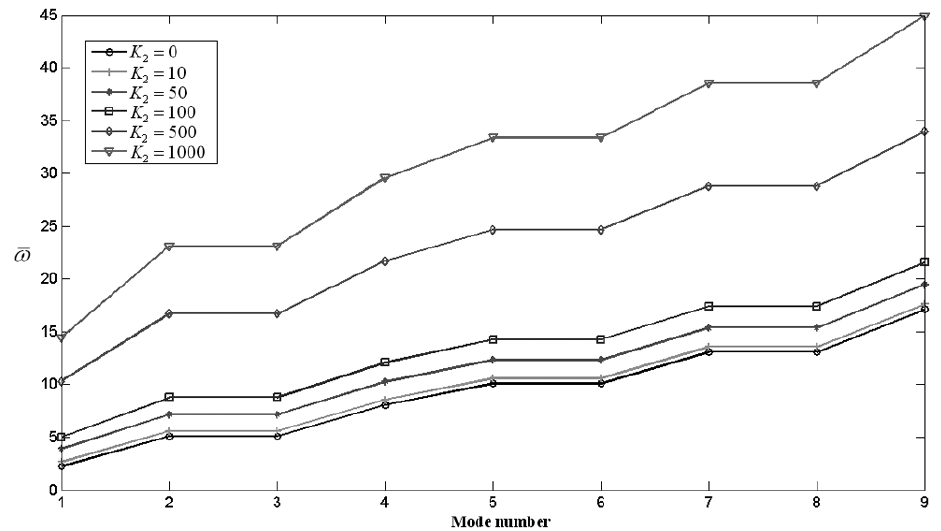
Fig. 4. Comparison of natural frequencies for Winkler and Pasternak’s type of elastic foundation ( K 1 = 100 ,h/a = 0 . 01 and number of nodes 19 ×